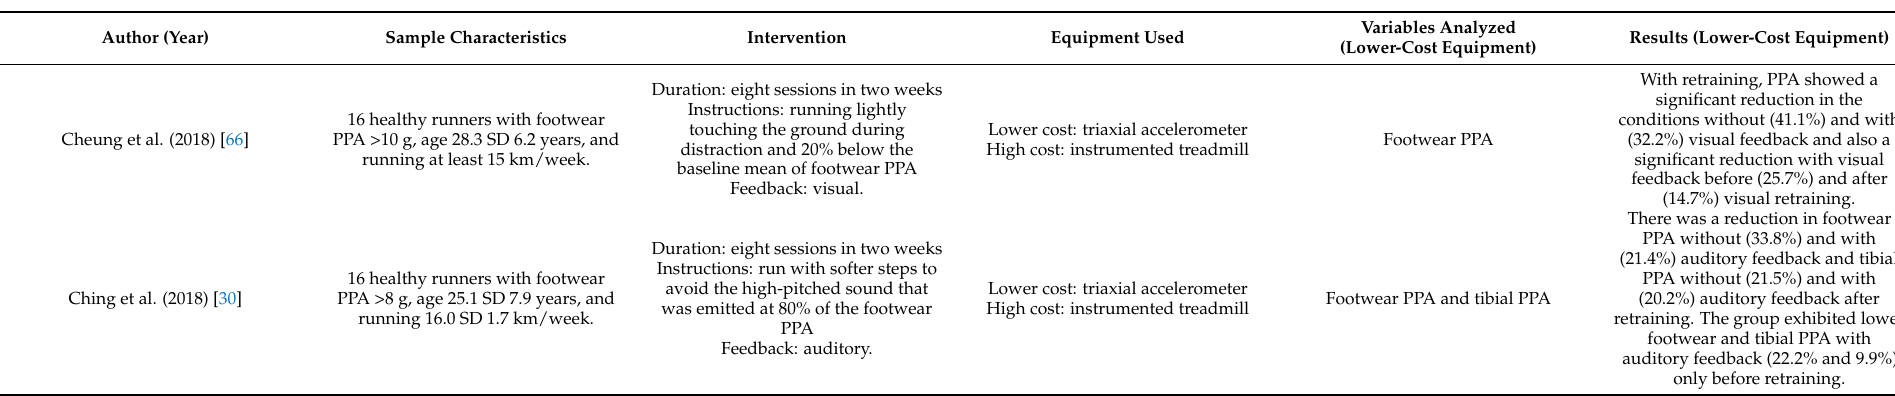
Table 5. Summary of experimental studies that analyzed the peak positive acceleration of tibia and footwear as a retraining strategy without the use of a control/comparative